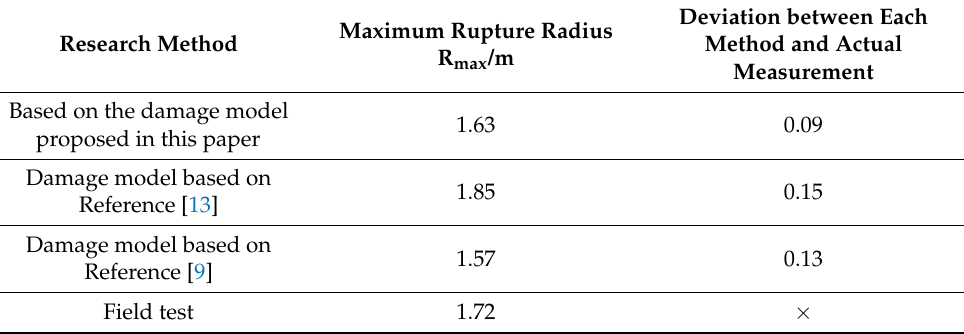
Table 1. Maximum fracture